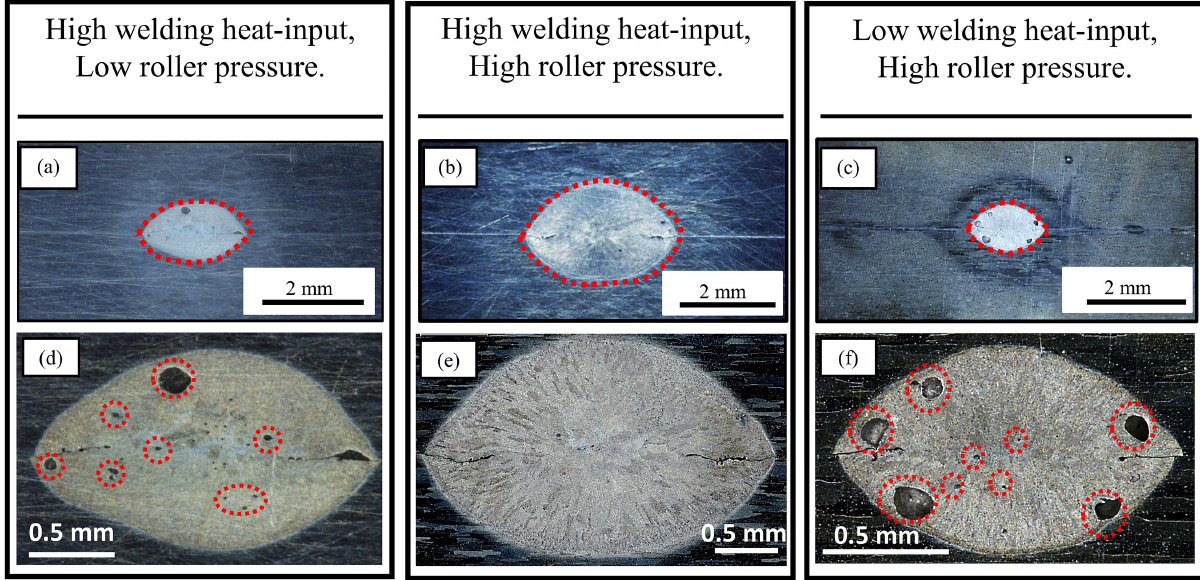
Figure 3: Macroscopic morphologies of fusion zones welded at various welding parameters: (a) heat input (HI, J mm −1 ) = 81.9, roller pres- sure (P, MPa) = 40; (b) HI = 81.9, P = 180; (c) HI = 54.6, P = 180; (d-f) enlarged images of cross-sections shown in (a-c).